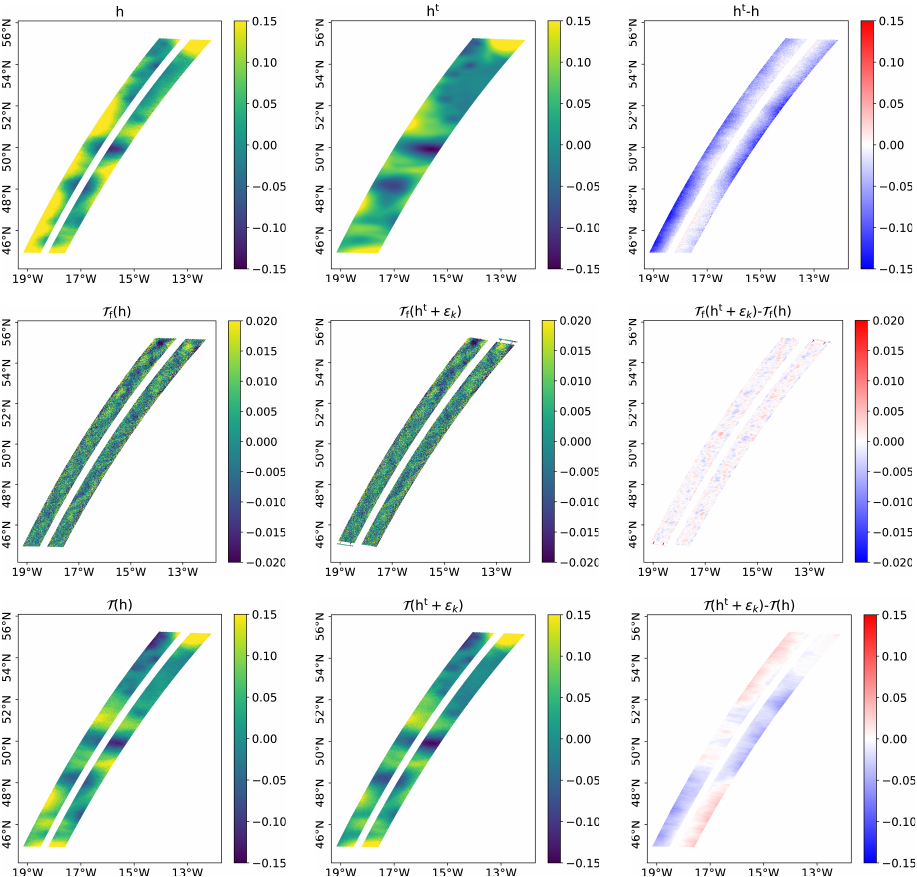
Figure 4. SSH (in meters) on pass “p031” of cycle 17 given by the SWOT data h (first row—left), the true SSH field h t (first row—center), and their difference (first row—right); by the fully detrended (different scale) SWOT data T f ( h ) (second row—left), the fully detrended truth + KaRIn error T f ( h t + (cid:101) k ) (second row—center), and their difference (second row—right); and by the partially detrended SWOT data T ( h ) (third row—left), the partially detrended truth + KaRIn error T ( h t + (cid:101) k ) (third row—center), and their difference (third